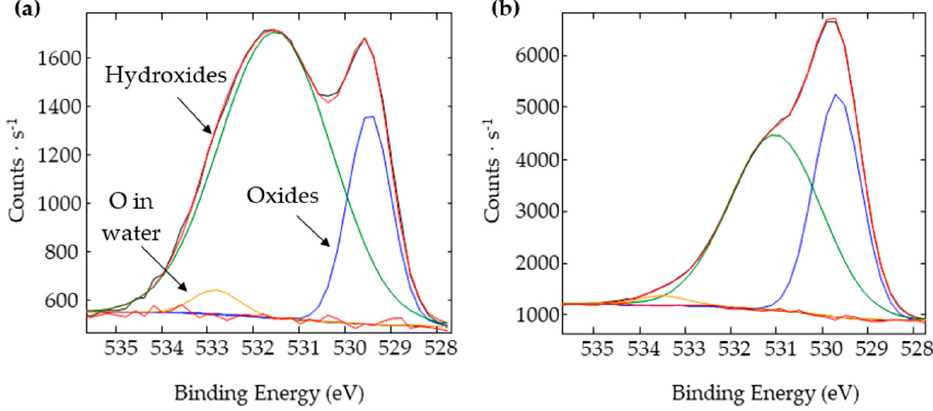
Figure 17. Deconvolution of the O1s spectra of the samples with no square pillars’ top irradiation textured under a CO 2 flow for which wetting evolution measurements were ( a ) carried out and ( b ) not carried out.